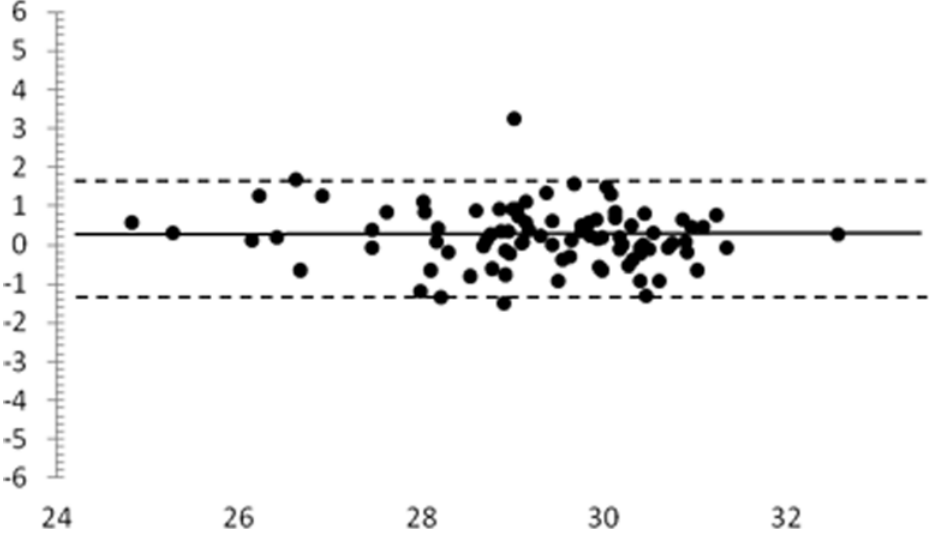
sensitivity of the two tests (dB).